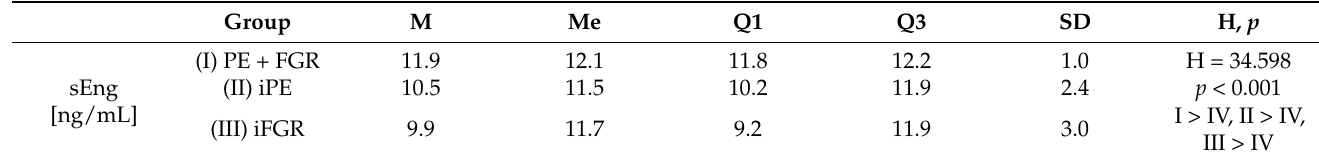
Table 5. Distributions of the values of sFlt-1, sEng, PlGF and the sFlt-1/PlGF and sFlt-1*sEng/PlGF ratios in women with isolated PE, isolated FGR, combined PE and FGR and in the control group (based on the results of the Kruskal-Wallis test with Bonferroni